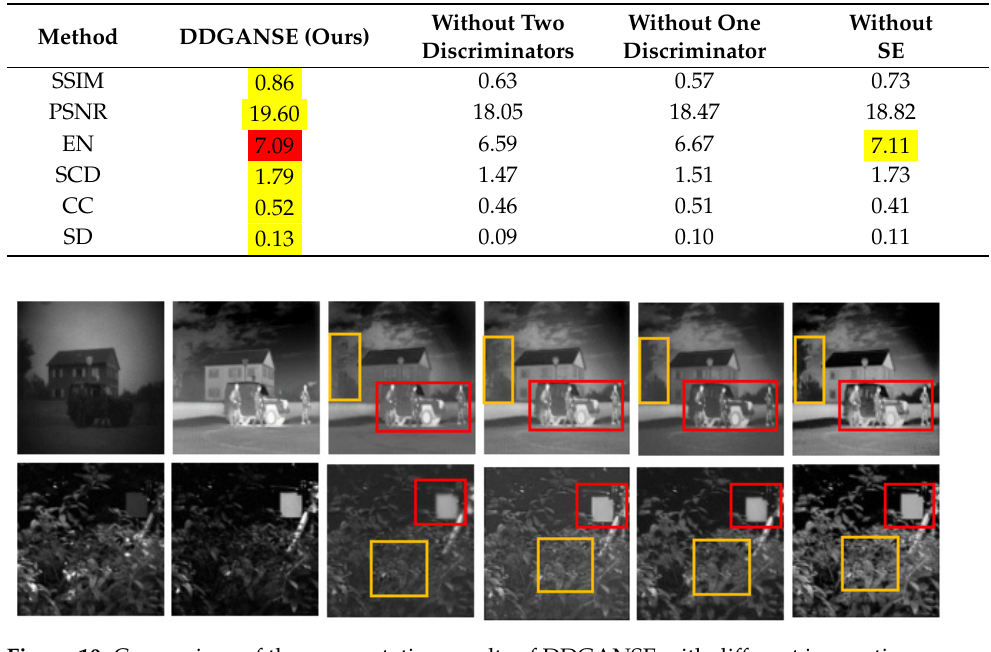
Figure 10. Comparison of the segmentation results of DDGANSE with different innovative compo- nents. From left to right: visible images, infrared images, and fused results of DDGANSE without two discriminators, DDGANSE without one discriminator, DDGANSE without the SE module, and the complete DDGANSE.